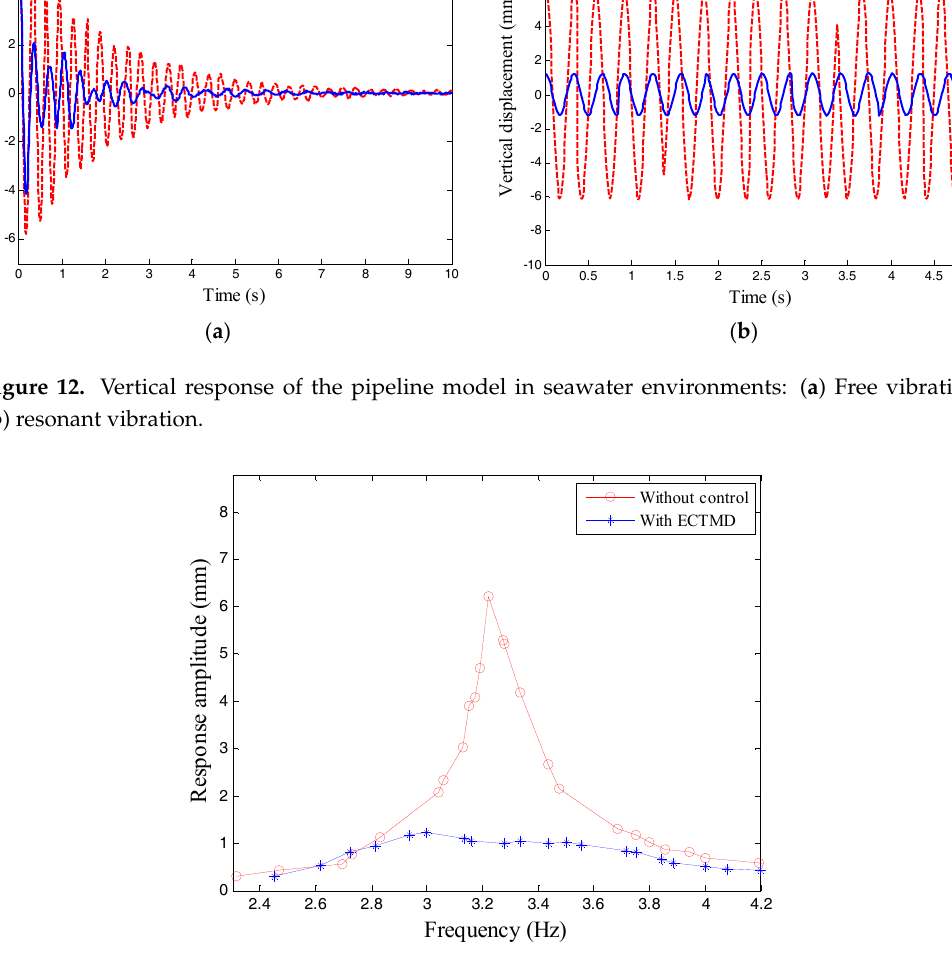
Figure 13. Vertical response of the pipeline model in a large frequency domain.